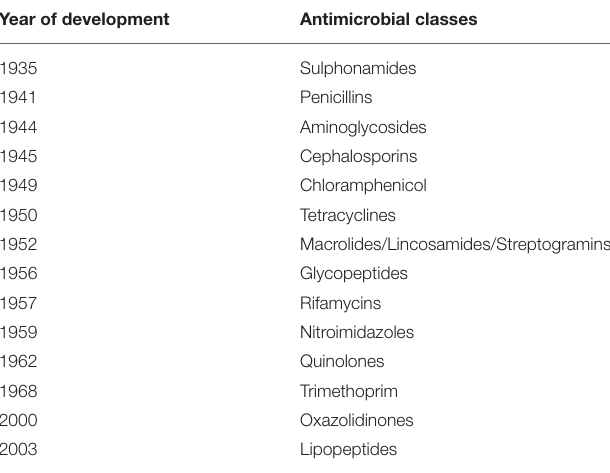
TABLE 1 | Novel classes of antibiotics developed between 1935 and 2003 (99,